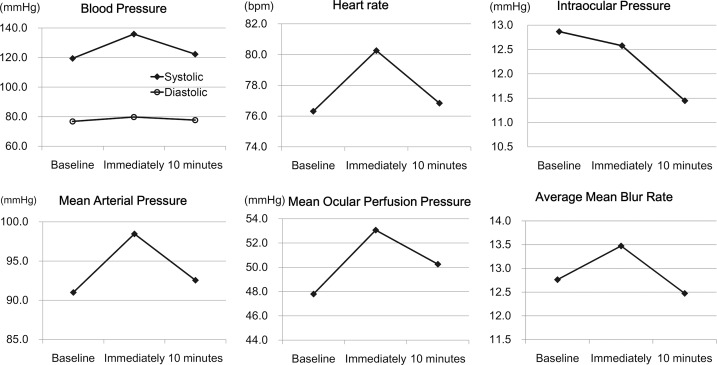
Changes in the hemodynamic parameters.All hemodynamicparameters were significantly increased immediately after the exercise, and they decreased at 10 minutes after the exercise.